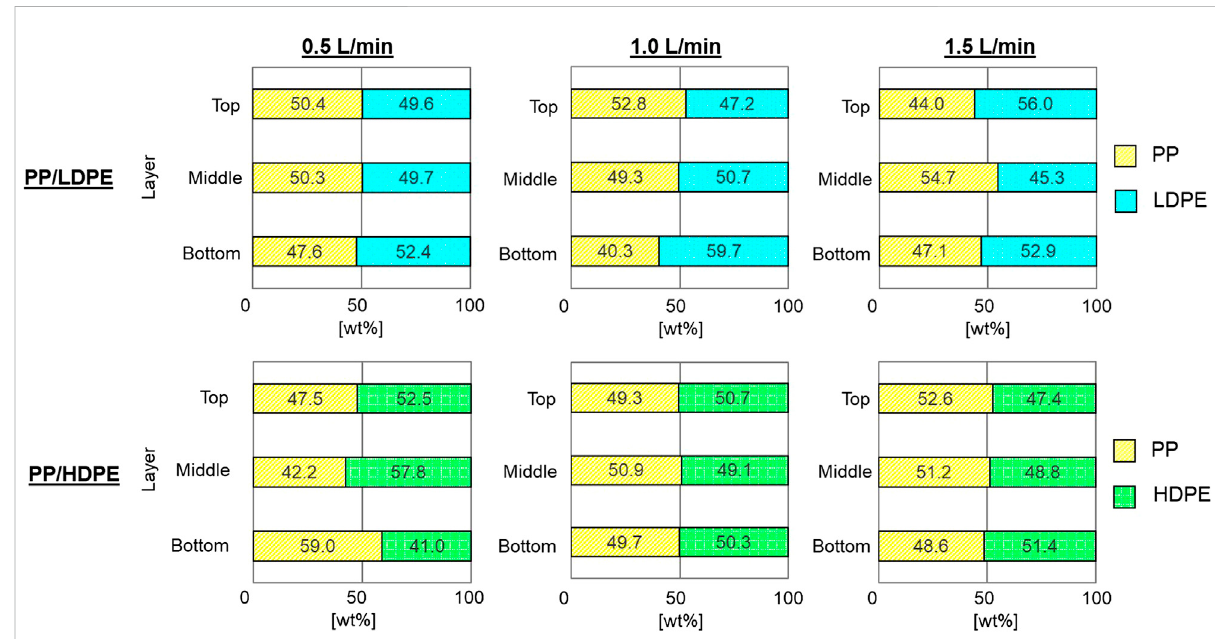
FIGURE 5 The proportion of plastics in each layer after reverse hybrid jig separation of PP/LDPE and PP/HDPE with continuous bubble generation at different air fl ow rate of 0.5, 1.0, and 1.5 L/min in water (i.e., without wetting